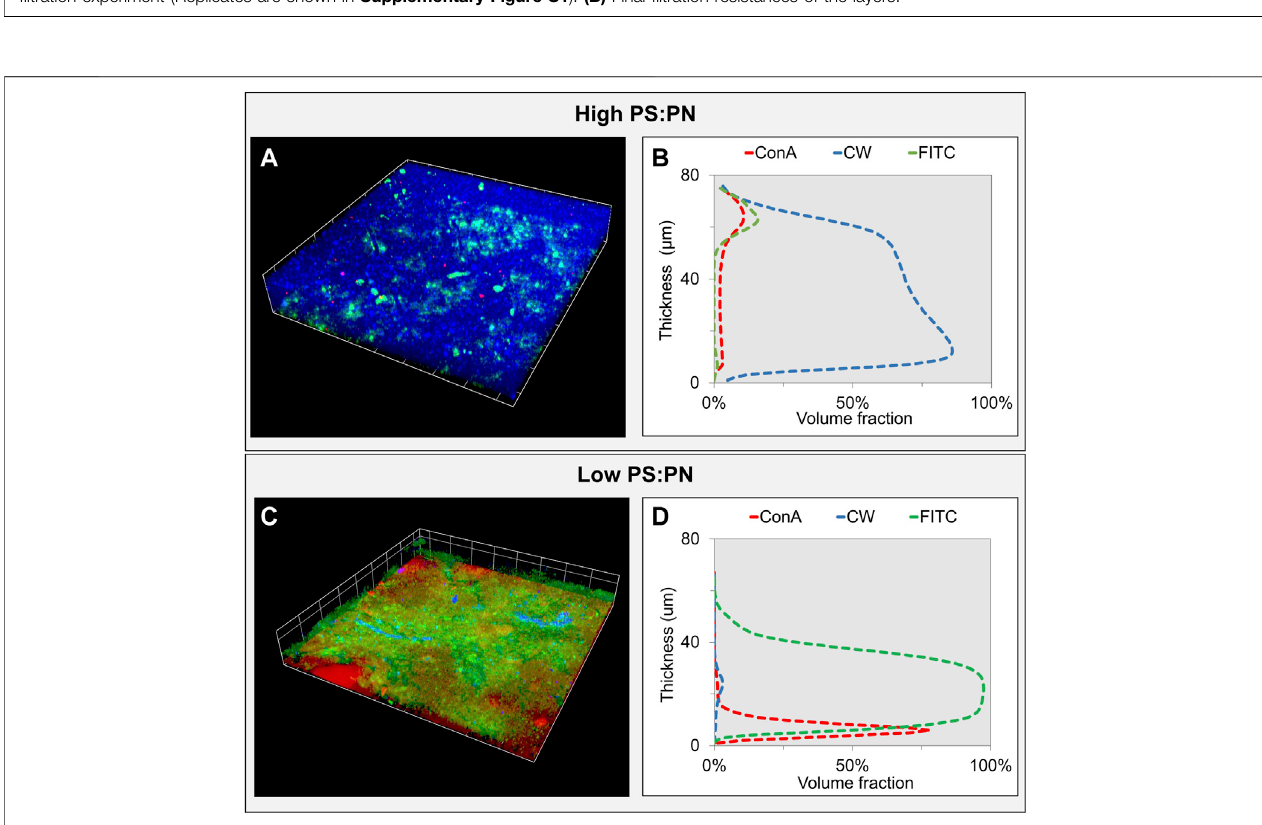
FIGURE 4 | Confocal laser scanning microscopy (CLSM) analysis of the sEPS layers — 3D volume reconstruction of CLSM stacks of the sEPS layers formed with high (aerobic) (A) and low (anaerobic) (C) PS:PN sEPS after fl uorescent staining of biopolymers. In blue, the β -polysaccharides were stained with calco fl uor white, in red the α -polysaccharides stained with Concanavalin A, and in green, the proteins stained with FITC. The biovolume analysis of each stained biopolymer within the gel layer formed with high and low PS:PN sEPS is presented in (B) and (D) , respectively.